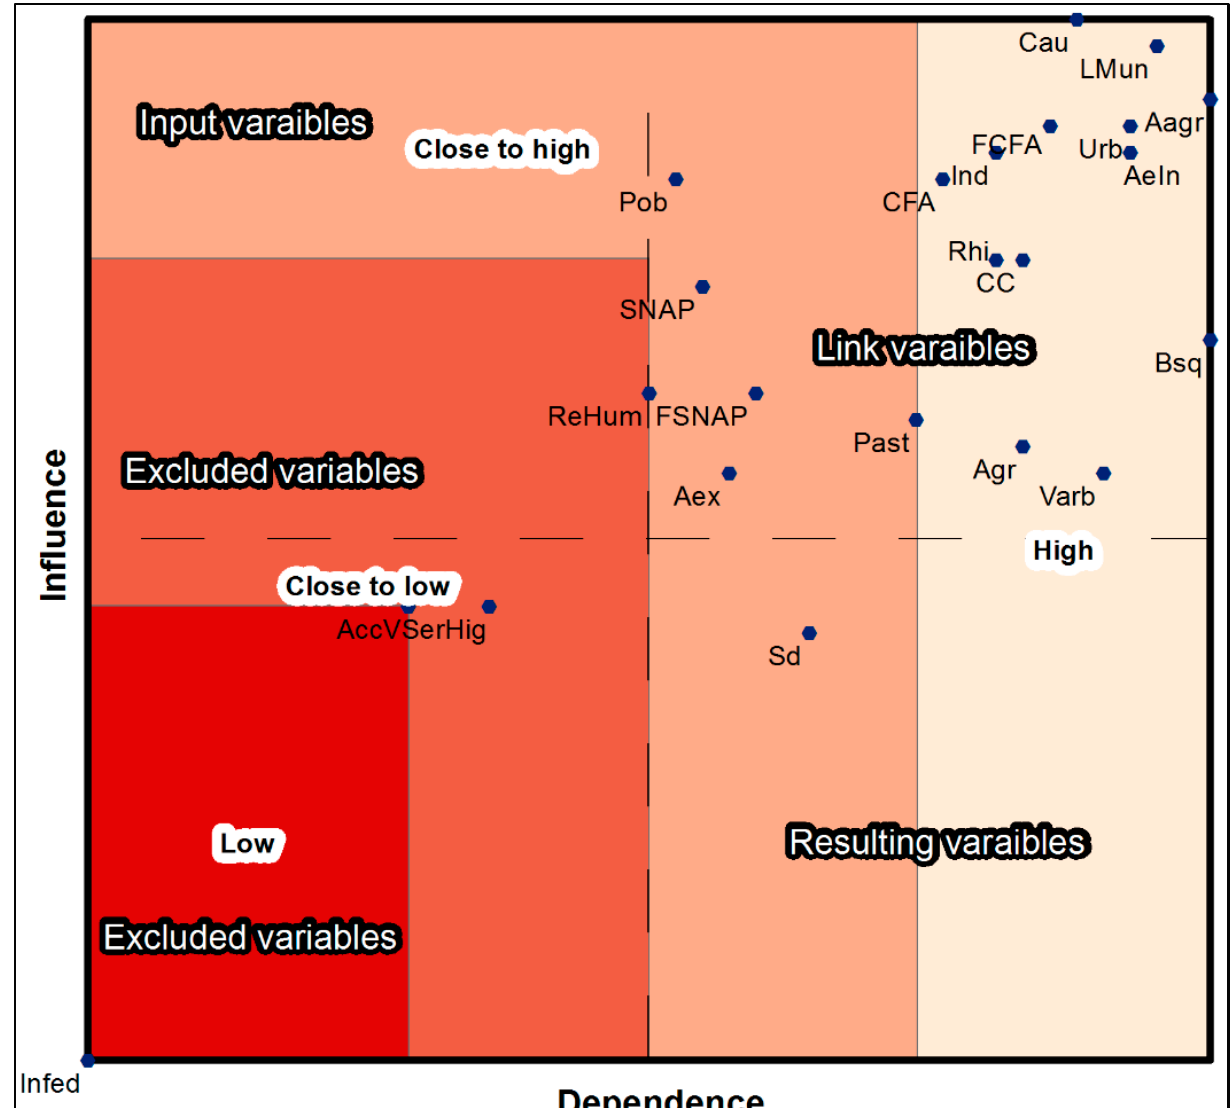
Figure 3. DI graph for ZH basin.